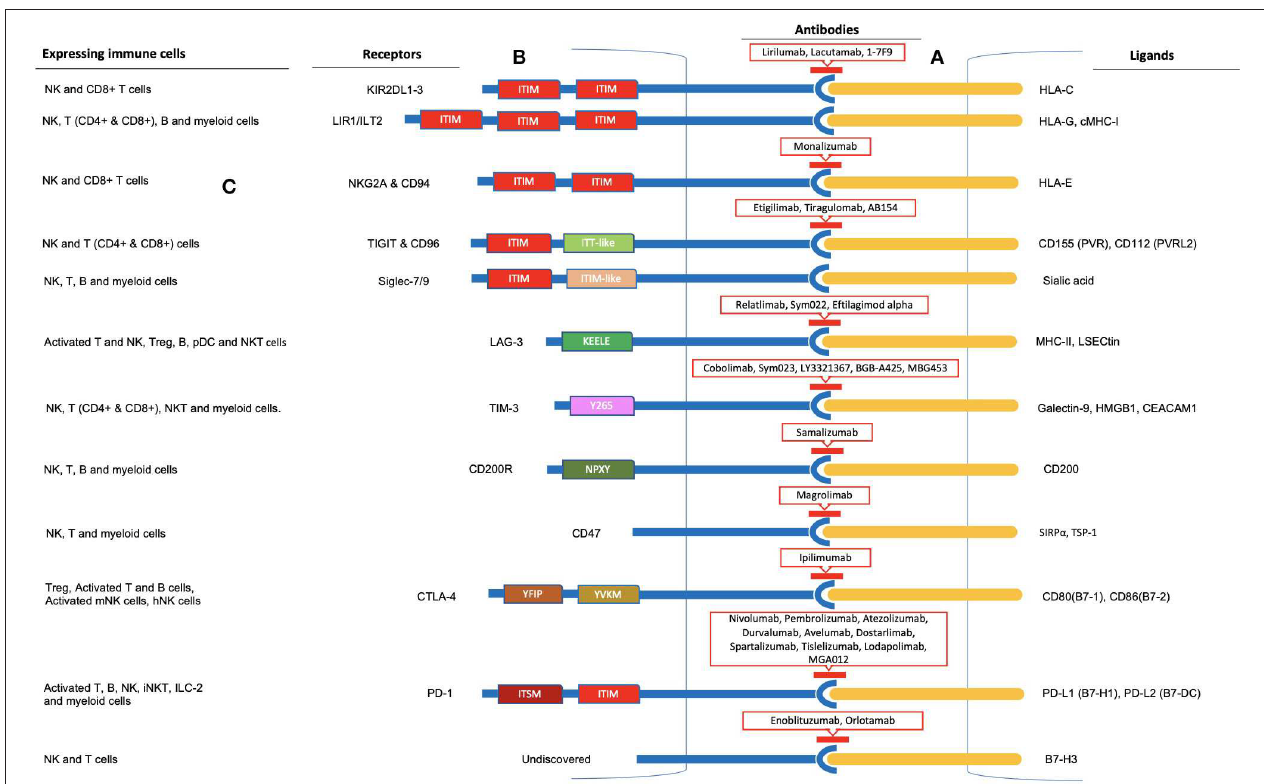
FIGURE 2 | Immune checkpoint inhibition observed in Natural Killer cells. (A) Inhibitory receptor-ligand interaction leading to immune escape of cancer cells is termed immune checkpoint inhibition. Inhibitory receptors expressed on the surface of NK cells are illustrated as blue rods, and ligands for these receptors expressed by tumor cells are illustrated as orange rods. (B) Rectangular boxes represent the intracellular domains of the receptors through which inhibition is carried out. Several of these receptors (KIR, ILT2, NKG2A & CD94, TIGIT & CD96, Siglec-7/9, PD-1, and SIRP α ) bear 1-3 ITIMs in their cytoplasmic tail and observe ITIM-based inhibition. In addition, TIGIT and PD-1 cytoplasmic tails contain an ITT-like and ITSM motif, respectively. LAG-3, TIM-3, CD200, and CTLA-4 lack an ITIM motif in their cytoplasmic tails. Instead, they have special intracellular tyrosine motifs such as KEELE, Y265, NPXY, and YVKM and YFIP, respectively, which are implicated in carrying out the inhibition process. Antibodies to these receptors are shown within red-outlined boxes. (C) Moreover, several other immune cells, including T cells, B cells, and myeloid cells, express these receptors on their surfaces, as shown on the left panel for each immune checkpoint